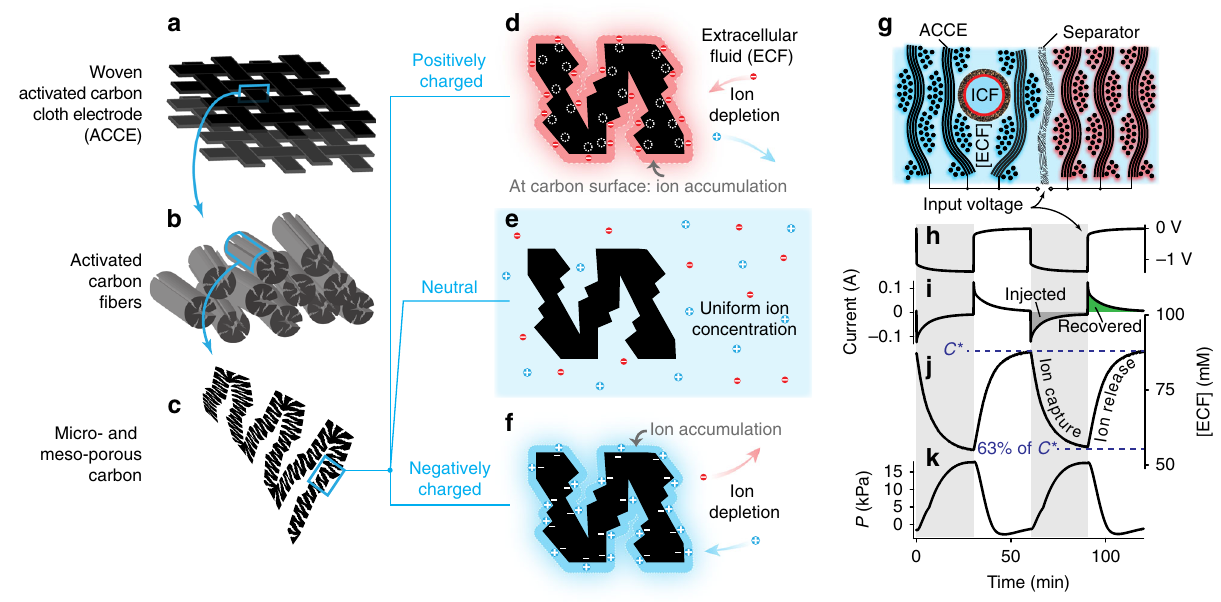
Fig. 2 Electrosorption as a key mechanism to reversibly modulate osmolyte concentration. a – c Hierarchical structure of the activated carbon cloth electrodes (ACCEs): a textile woven from b bundles of binderless fi bers provide ion passage pathways, whereas c porous carbon provides a large speci fi c surface area enhancing ion electrosorption capacity. d – f Close-up of d positively charged, e neutral, and f negatively charged ACCE. g In situ measurement (schematic) of ion concentration ([ECF]) and pressure ( P ). h Input voltage (1.3 V). i – k Measured i current, j concentration and k pressure difference, using sodium sulfate (Na 2 SO 4 ) as electrolyte. The measured trends highlight a reversible behavior; the colored areas in ( i ) illustrate that 90% of the initially injected charge was